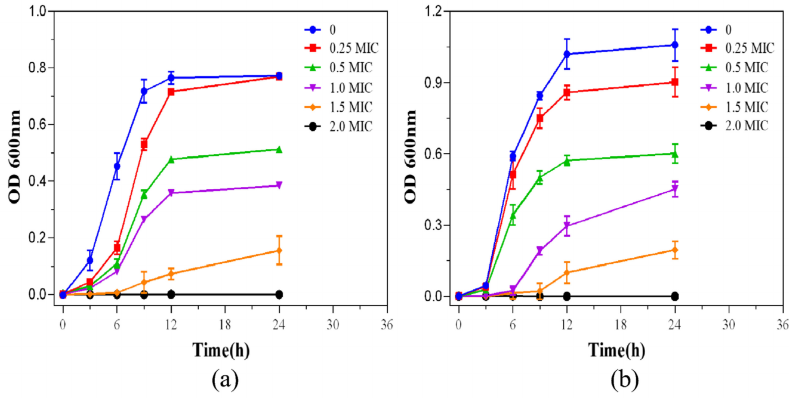
Figure 8. Growth inhibition curves of E. coli ( a ) and S. aureus ( b ) at different